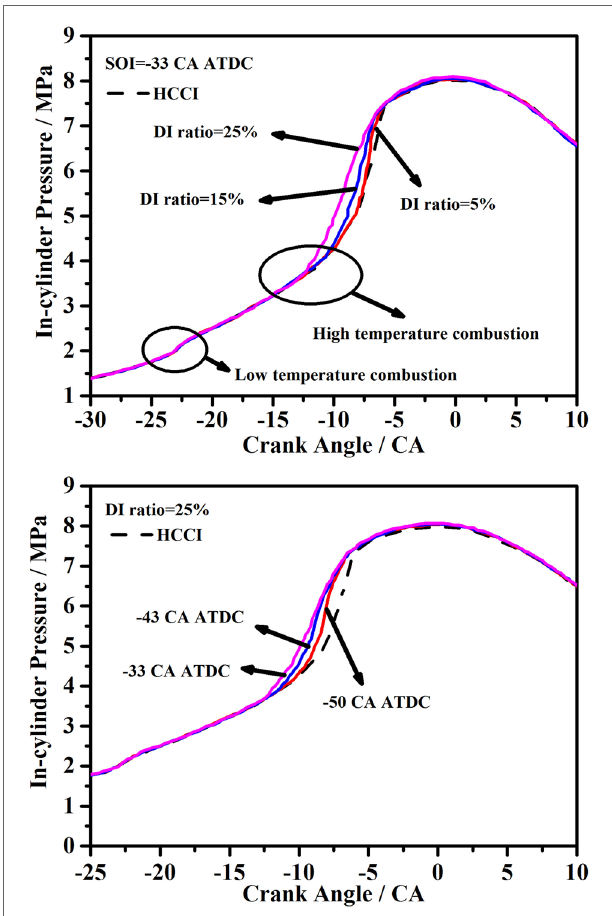
FiGURe 5 | effects of Di ratio and timing on combustion process in charge stratification combustion mode